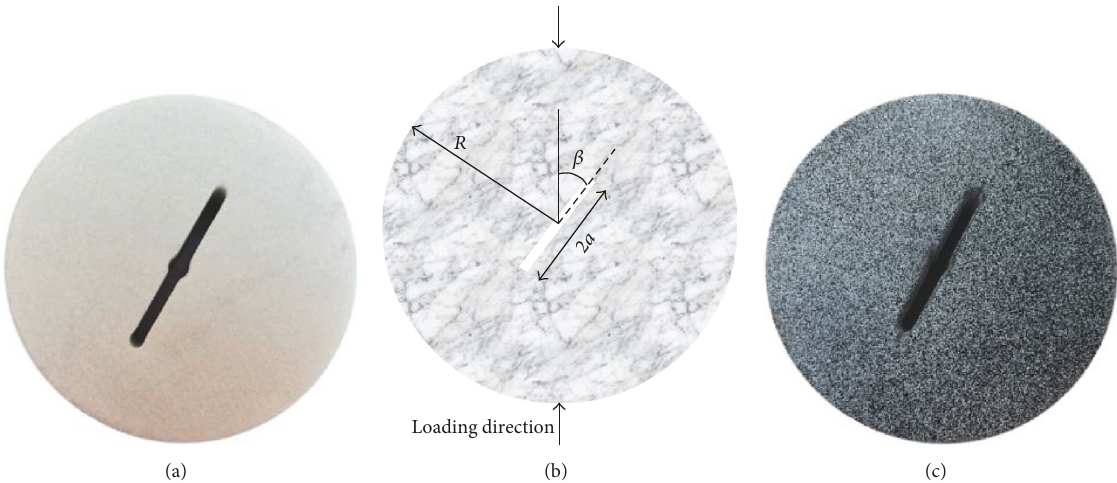
Figure1:PicturesofthecentralstraightthroughBraziliandiscs(CSTBD):(a)acentralnotchedBraziliandisc;(b)thegeometryoftheCSTBD; (c) a typical speckle